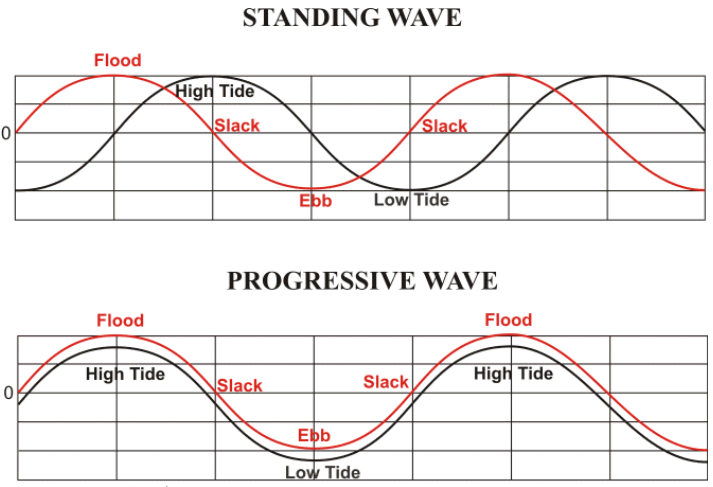
Figure 4. Standing wave and progressive wave.